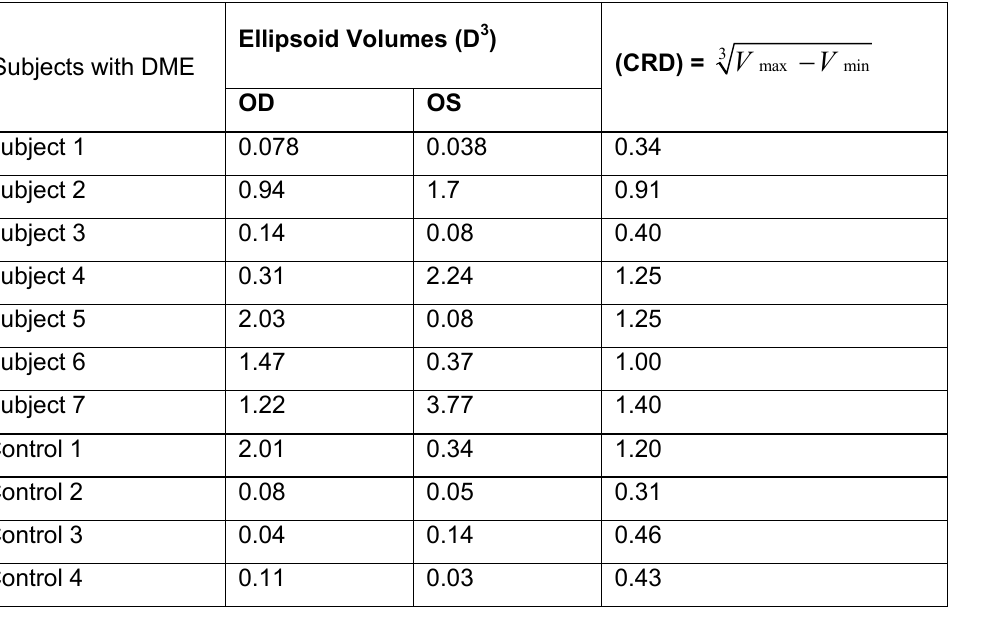
Table 2 .The Cubic Root Differences (CRD) of distribution ellipsoids for right and left eyes of subjects with and without (control subjects) DME. The bigger the CRD, the greater the difference in volumes between the eyes. Units are m -1 or D whereas volumes have units D 3 . The mean CRD for DME subjects was 0.94 and for control subjects 0.60 indicating that overall subjects with DME displayed larger ellipsoidal volumes compared to subjects without DME